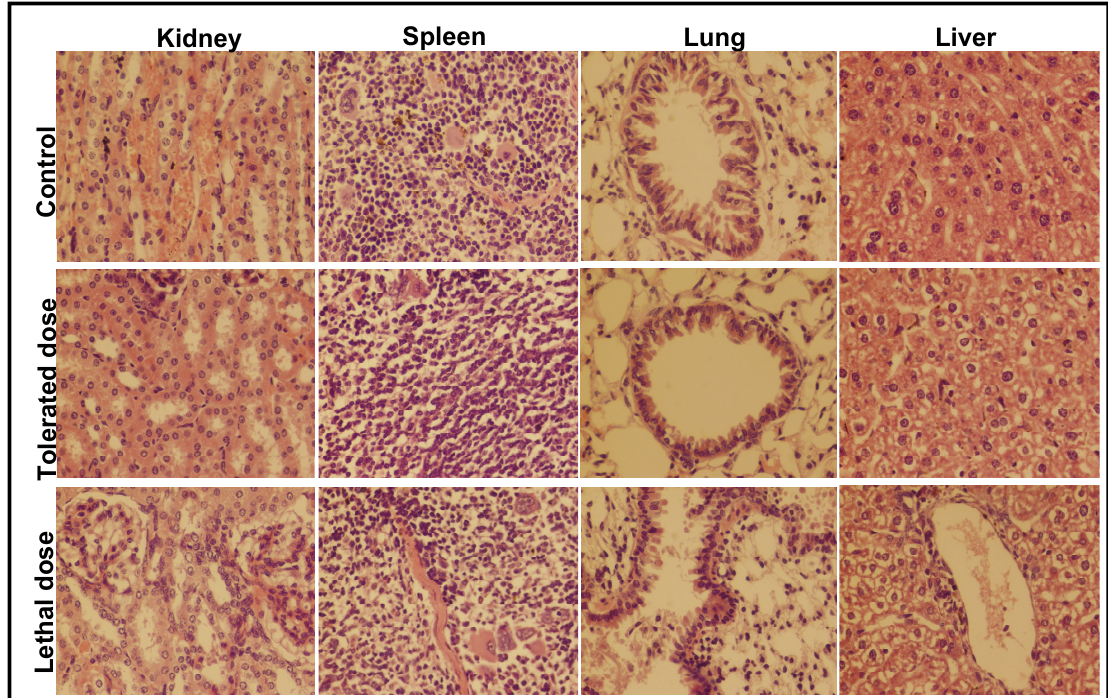
Figure 6. The histopathological examination of the kidney, spleen, lung and liver of mice after injecting a low and a high dose of Fe 2 O 3 NPs for 14 days; tolerated dose (14 ppm) and lethal dose (20 ppm).